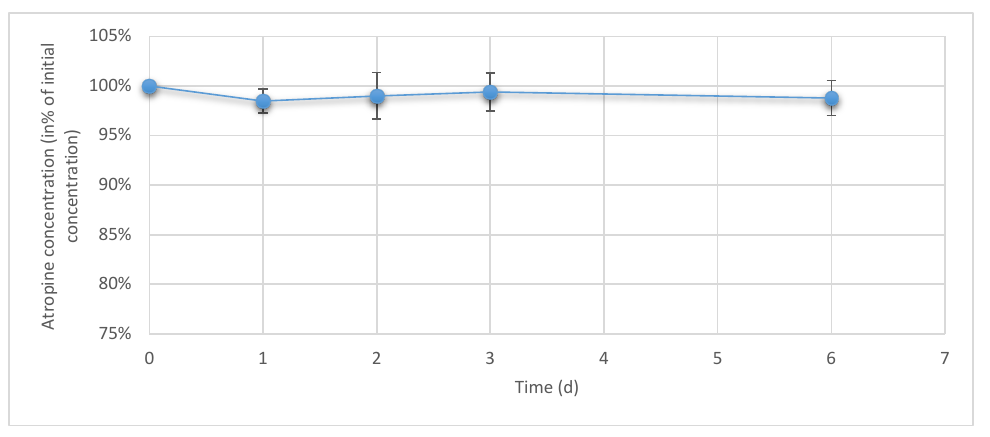
Figure 7. Evolution of atropine concentration in the emitted drops during simulated use ( n = 3 times 10 pooled drops, mean ± 95% confidence interval).